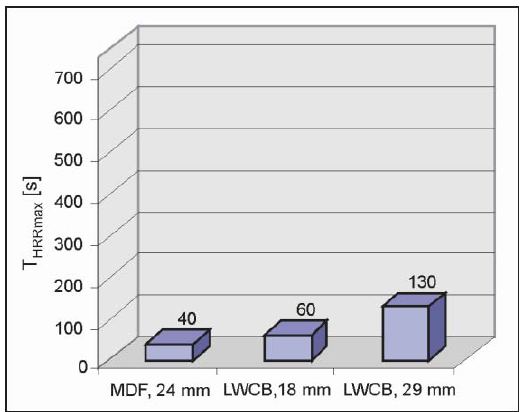
Fig. 9. Mean time to maximal heat release rate (T HRRmax ) when exposed to the surface heat flow density of 50 kW/m 2 for diffe- rent tested boards